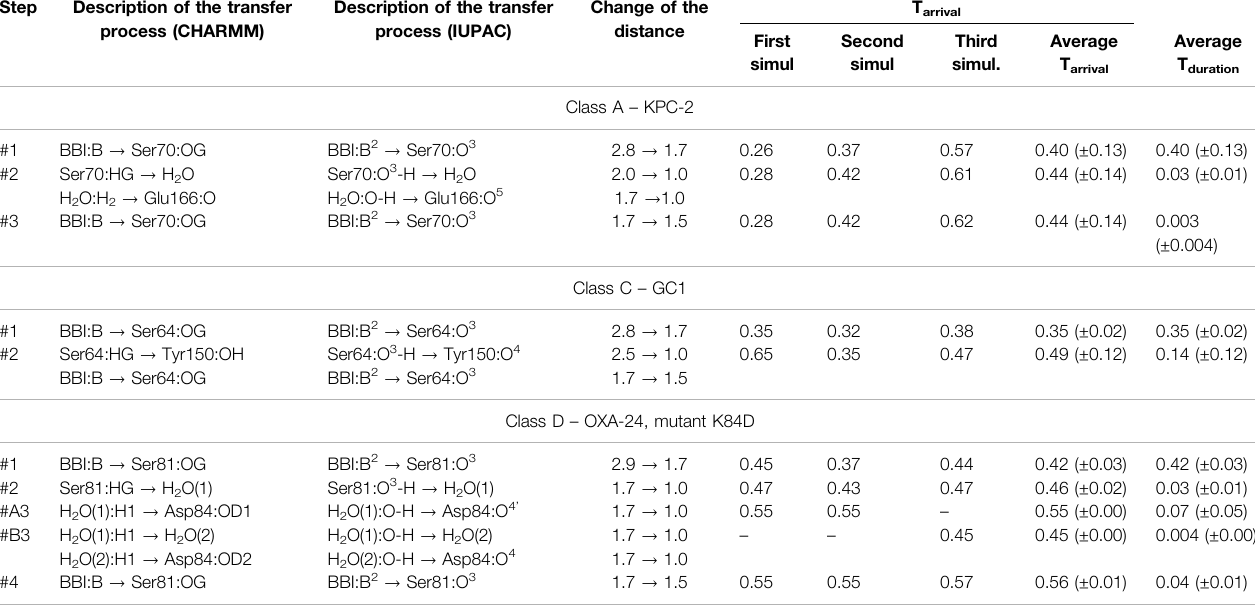
TABLE 2 | Approximate time-periods characterizing the covalent docking process between the bicyclic boronate inhibitor (BBI) and the members of the A, C, and D β -lactamases classes.T arrival isthetimetoreachagivenstateonthereactionpath, calculatedfrom thebeginningoftheprocess. T duration istheaveragetimetoreachthe nextstate, calculatedfromthepreviousone.All times,alongwiththeir standarddeviationsinparentheses,aregiveninps. Theatomic namesfollow theCHARMM force fi eld nomenclature as well as the IUPAC nomenclature, and show which atom has moved towards which atom in another molecular fragment. The distances describing the changes in geometry are given in Å. Graphical representations of the reaction steps are shown in Figures 7 , 8 . In class D, two distinct paths involving one or two H 2 O molecules in step #3 were observed, and are denoted as #A3 and